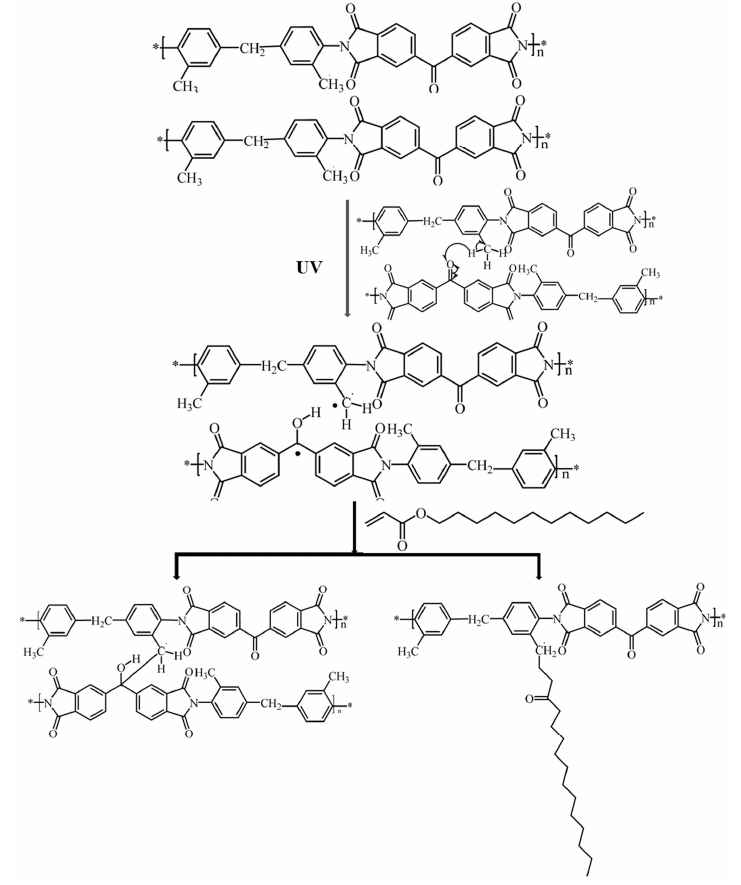
Figure 5. Scheme of the photoreaction of BTDA-DMMDA PI and DA monomers.